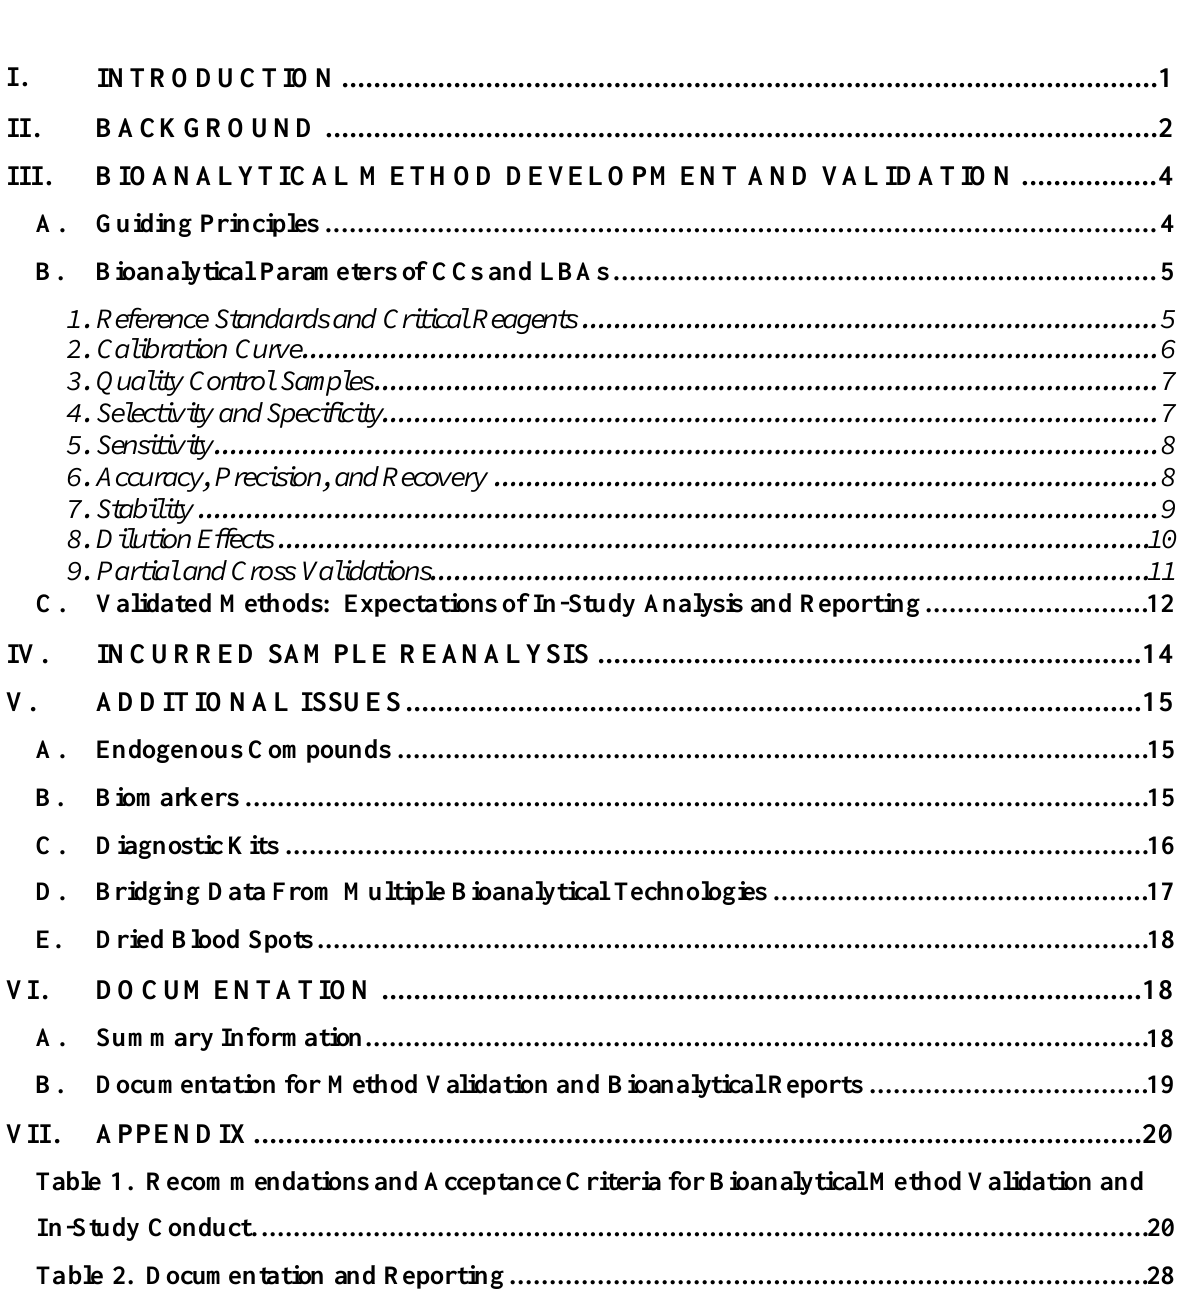
Table 1. Recommendations and Acceptance Criteria for Bioanalytical Method Validation